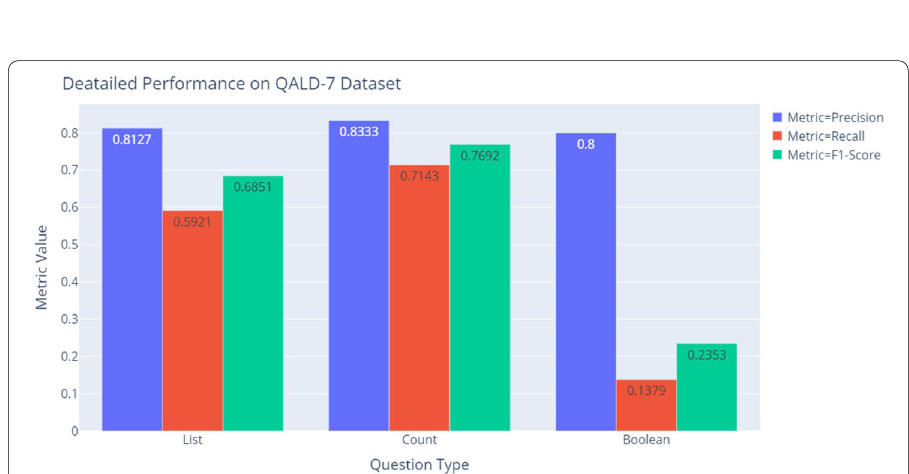
Fig. 8 Performance of each question type on QALD-7